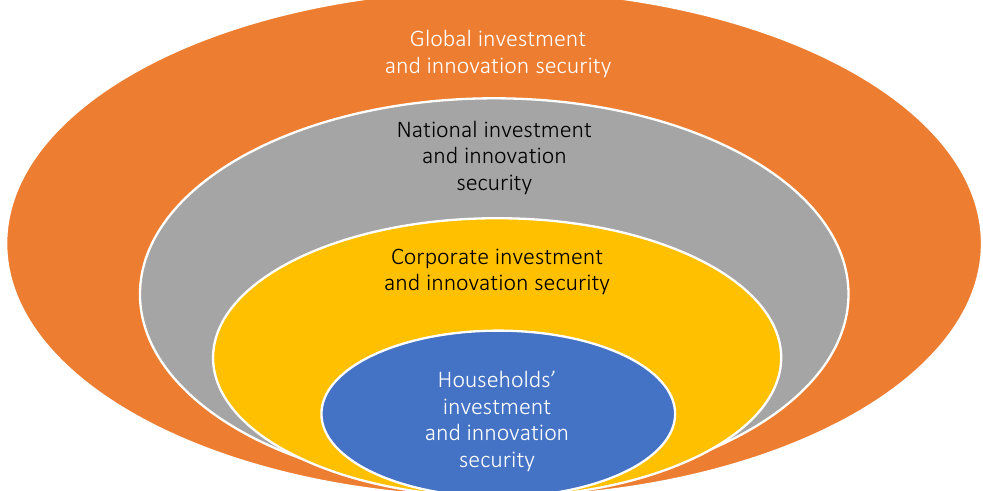
Figure 1. Leveled structure of investment and innovation security of the national